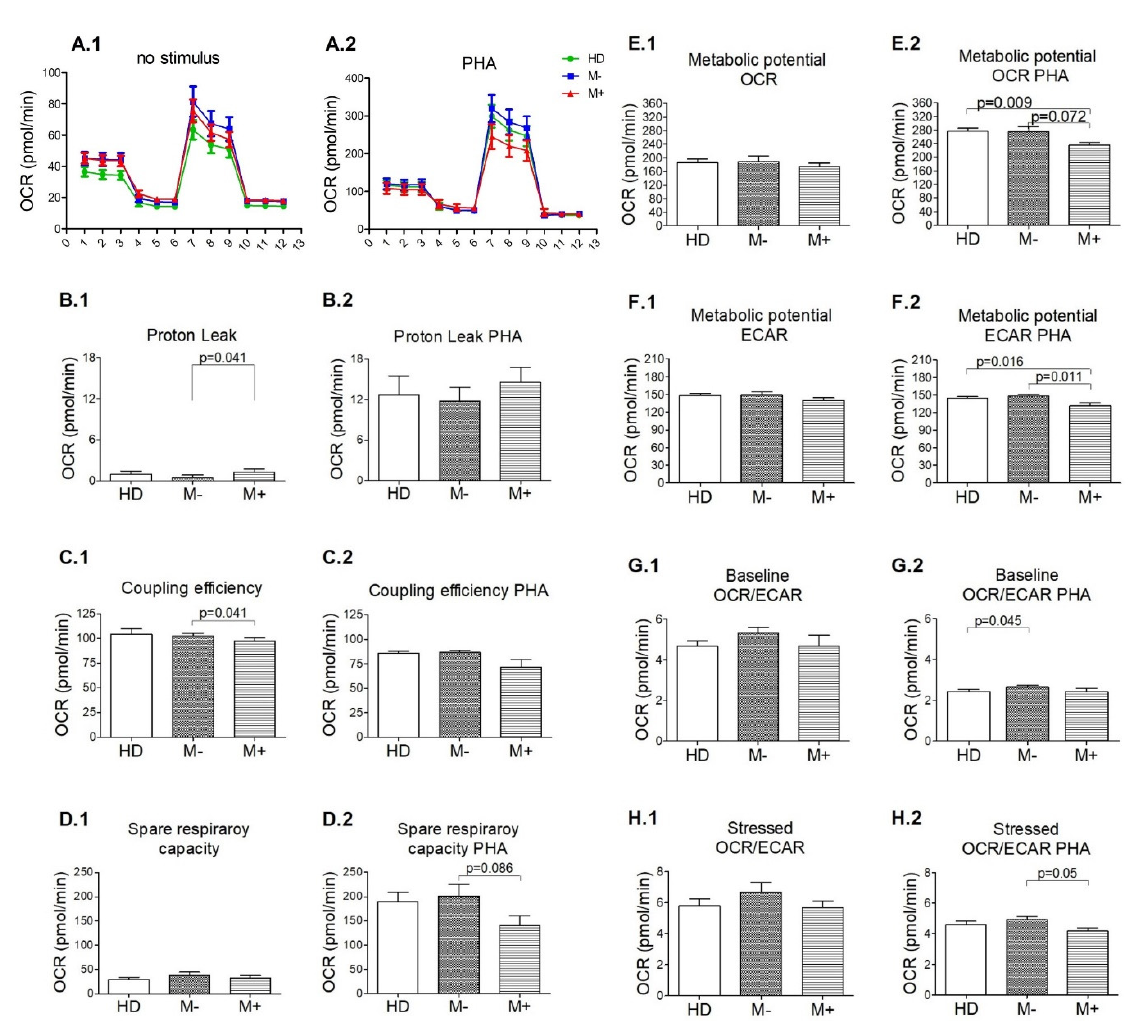
Figure 4. Mitochondrial dysfunction in the peripheral blood mononuclear cells (PBMCs) from mul- tiple sclerosis (MS) patients with lipid-specific oligoclonal immunoglobulin M bands (LS-OCMB) (M+). ( A ) Kinetic profile of oxygen consumption rate (OCR) of non-stimulated ( 1 ) and PHA-stimulated ( 2 ) PBMCs was measured in real-time under basal conditions and in response to mitochondria inhibitors: oligomycin, FCCP, and Antimycin A plus Rotetone. ( B , C ) The indexes of mitochondrial function were calculated from the OCR and extracellular acidification rate (ECAR) profiles of non-stimulated ( 1 ) and PHA-stimulated ( 2 ) PBMCs: proton leak ( B ), coupling efficiency ( C ), spare respiratory capac- ity ( D ), metabolic potential OCR ( E ), metabolic potential ECAR ( F ), baseline OCR/ECAR ( G ) and stressed OCR/ECAR ( H ). Healthy donors (HD) n = 17; M+: MS patients with lipid-specific oligo- clonal immunoglobulin M bands (LS-OCMB) in cerebrospinal fluid n = 10; M − : MS patients without LS-OCMB n = 9; PHA = phytohemagglutinin. Data were expressed as mean ± s.e.m. Comparisons were evaluated with the non-parametric test U